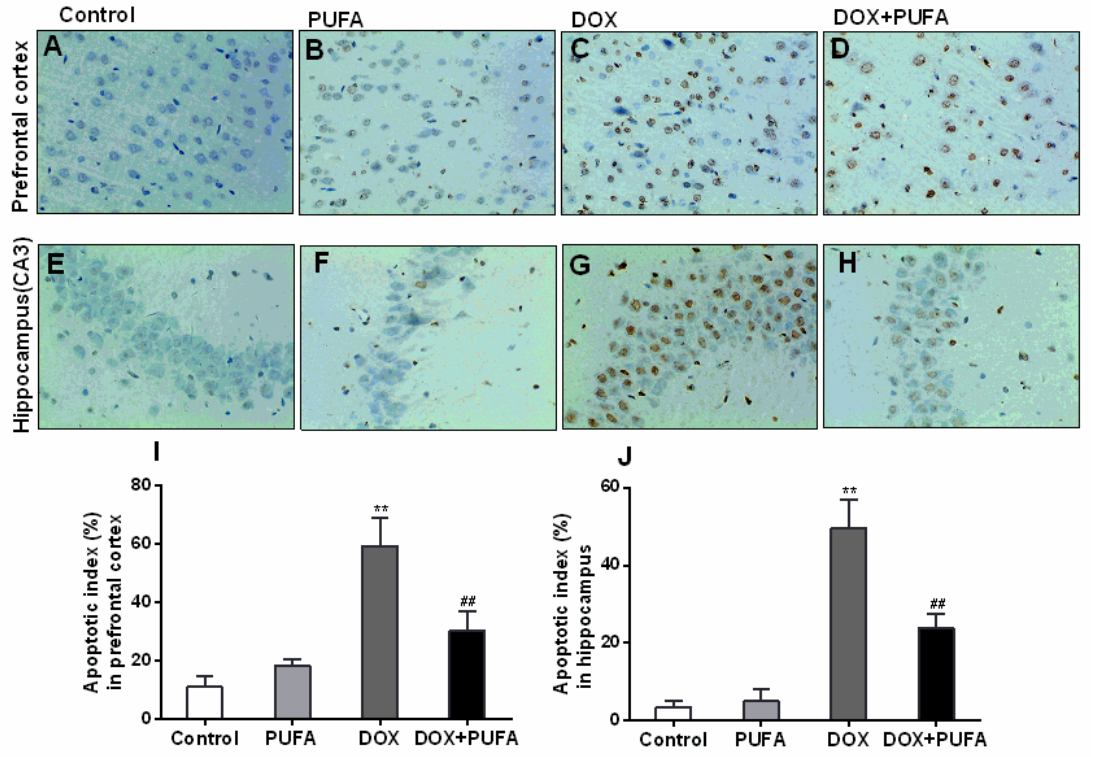
Figure 6. Effects of DOX and ω -3 PUFAs on TUNEL-positive cells in the prefrontal cortex and hippocampus. ( A )–( H ) show the TUNEL-staining positive cells through the light electric microscope followed by observation at 400×; ( I ) and ( J ) show the quantitative analysis of TUNEL results in the prefrontal cortex and hippocampus. Data are expressed as means ± SD ( n = 6–7). * p < 0.05, ** p < 0.01 compared to control group. # p < 0.05, ## p < 0.01 compared to the DOX-injected group.